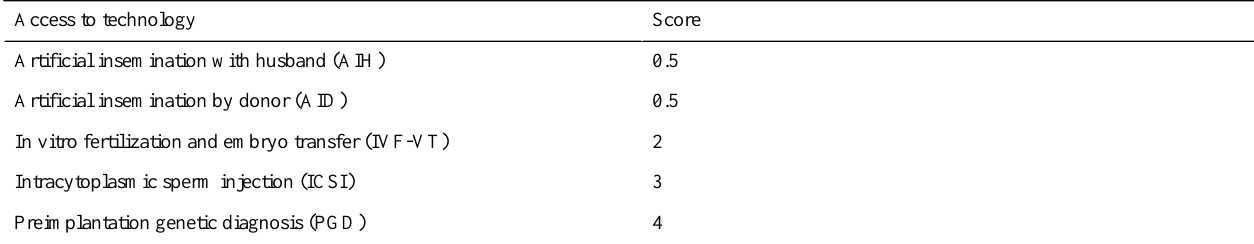
Table 1. Types and scores of assisted reproduction technology in medical